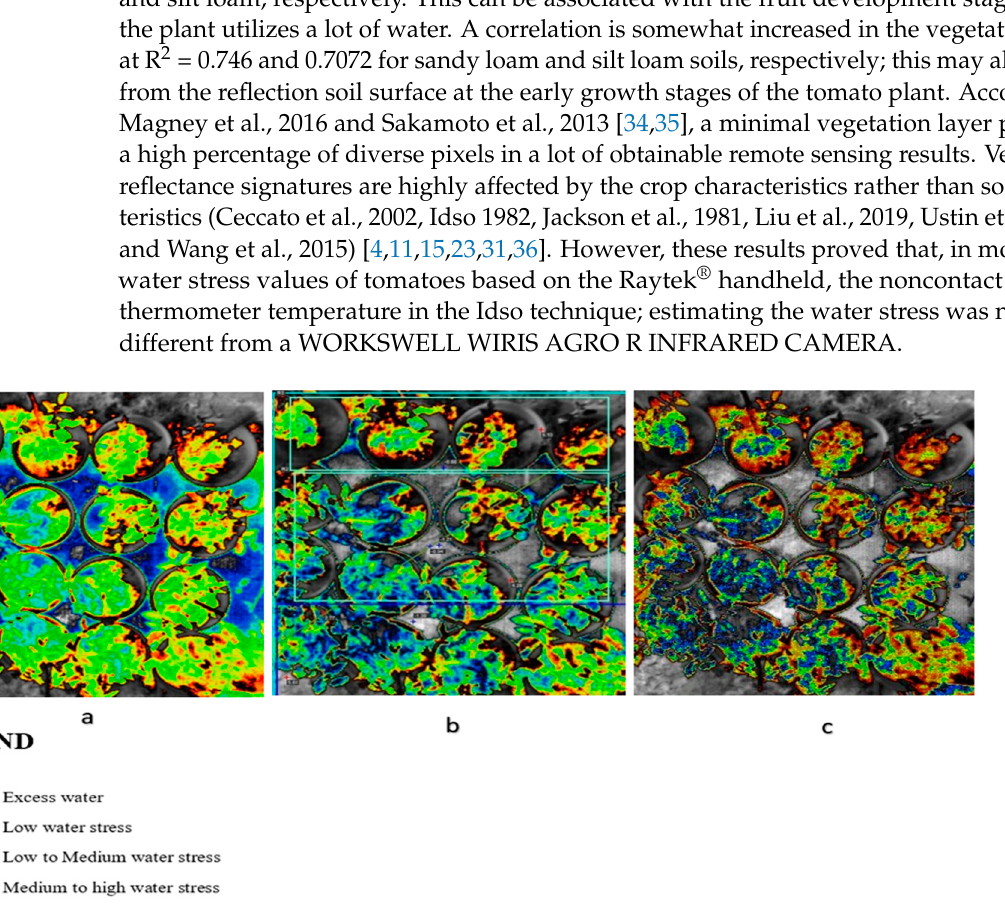
Figure 6. Image colors and corresponding CWSI values at different field capacities in tomato growths.